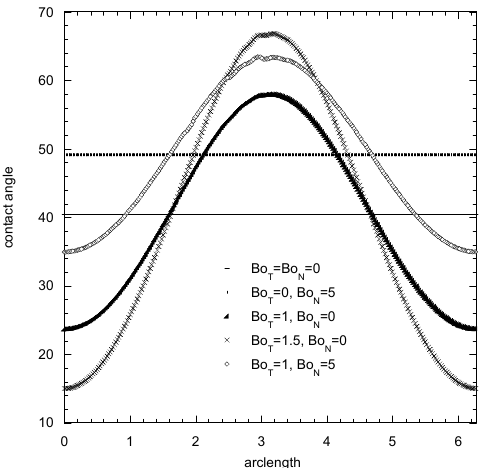
Figure 1. Contact angle (degrees) distribution along a pinned circular contact line for several values of normal and tangential Bond numbers. Dimensionless volume V = 0.6.